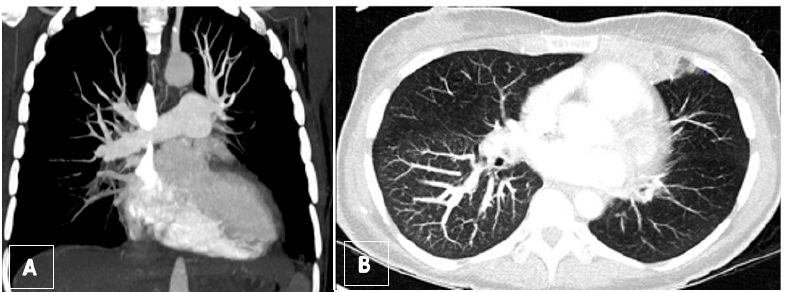
Figure 11. ( A ) Preoperative computed tomography angiography (coronar view) showing total occlusion of lower lobe arteries. ( B ) Axial maximum intensity projection (MIP) revealing the mosaic pattern with rarefication of vessels on left side as well as a hemorrhagic infarct in the lingula.